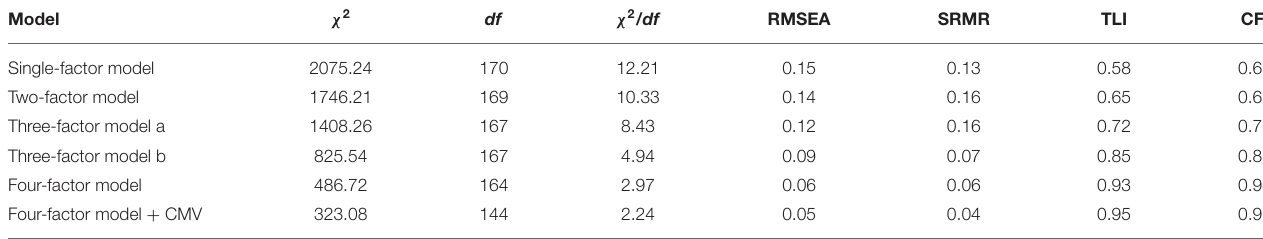
TABLE 2 | Confirmatory factor analysis results.